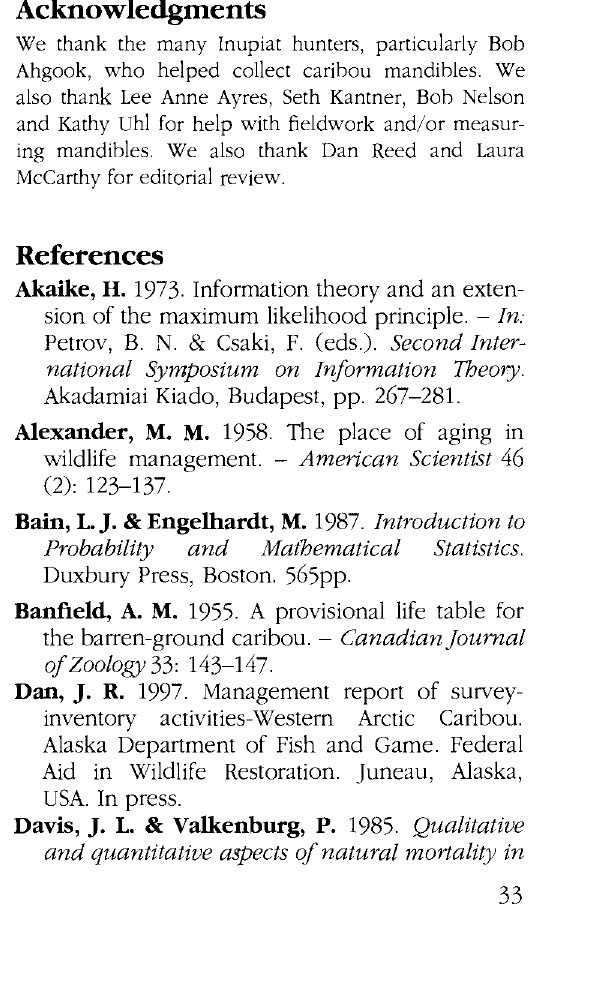
2. Fitted models of growth curves for diastema length from two collec tions of mandibles of male caribou from the Western Arctic caribou